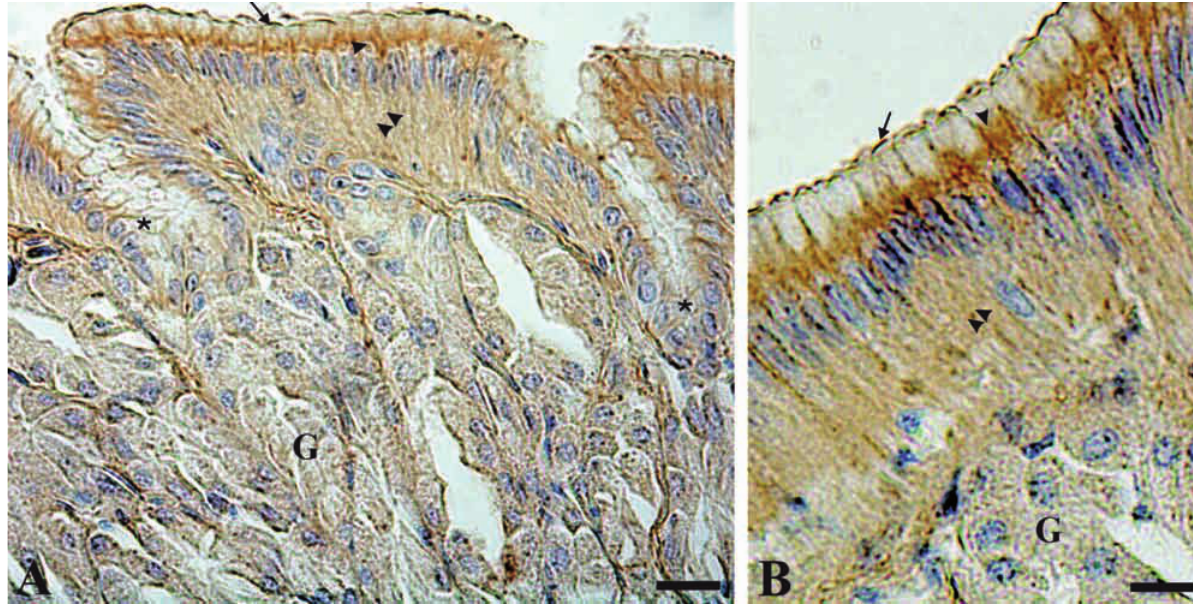
Fig . 3. – Mal ii (a) and Sna (B) binding pattern of Halobatrachus didactylus gastric mucosa. these two lectins display similar binding patterns as revealed by the reactivity for the luminal cell coat and the supra-nuclear zone of the epithelial columnar cells and the pit cells. Gastric glands show a negative reaction. G, gastric gland; arrow, luminal cell coat of surface epithelial cells; arrowhead, supra-nuclear zone; double arrowhead, sub-nuclear cytoplasm; asterisk, pit cells. Scale bars: a, 16 μm; B, 9 μm.